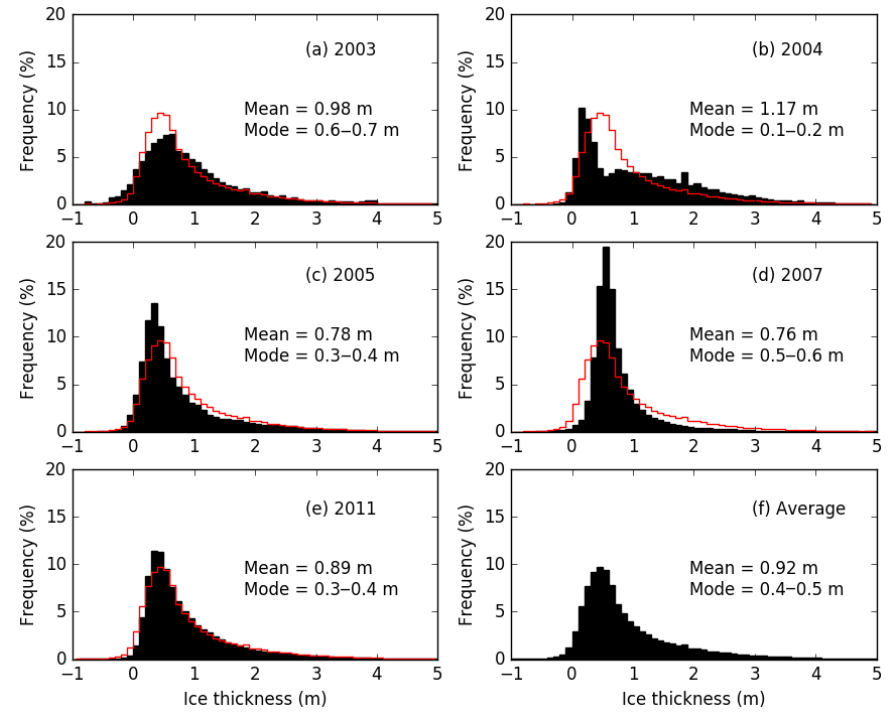
Figure 7. Frequency histograms of all helicopter EM ice thickness measurements in (a) 2003, (b) 2004, (c) 2005, (d) 2007, and (e) 2011 (in black). The average of all years is in panel (f) and in red in other panels. To avoid areal focus we have first calculated histograms in 1 × 1 NM 2 grid for each grid point and then averaged all histograms from the grid